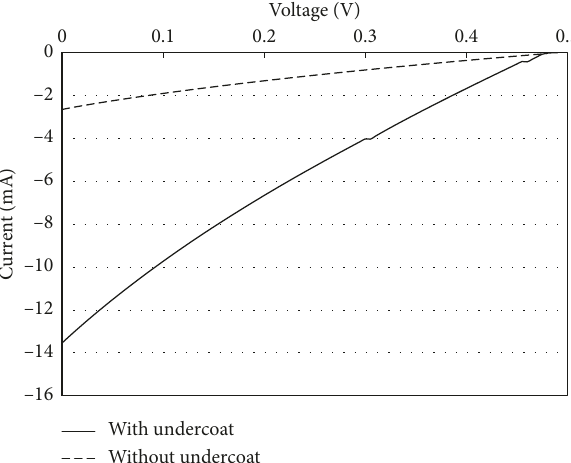
Figure 6: Ideal I-V characteristics of DSC.